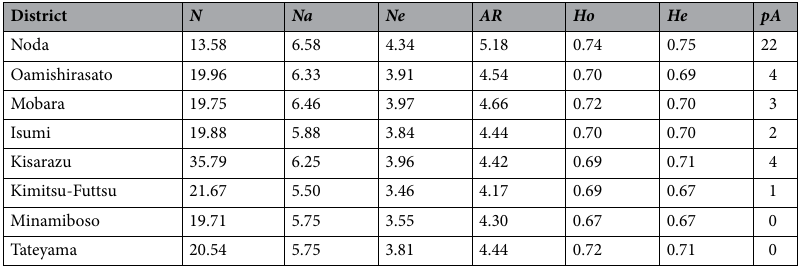
Table 3. Genetic diversity of each district for raccoons in Chiba prefecture, Japan. N mean of the number, Na estimated number of the alleles, Ne effective number of alleles, AR mean of the allelic richness, Ho observed heterozygosity, He expected heterozygosity, pA number of the private alleles.